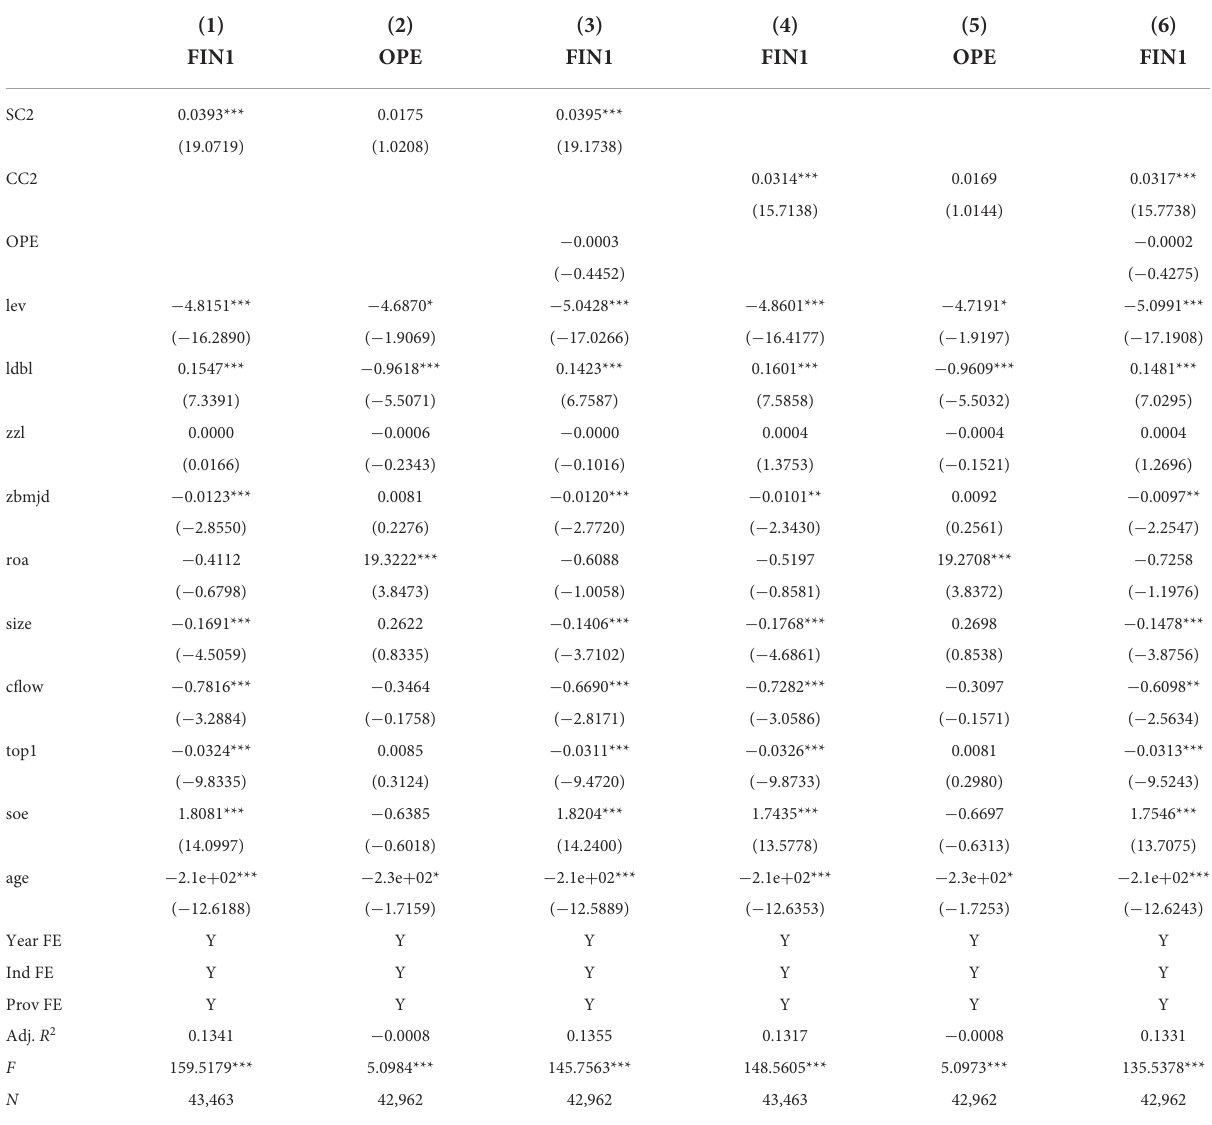
TABLE 5 Mediating effect of main business profitability